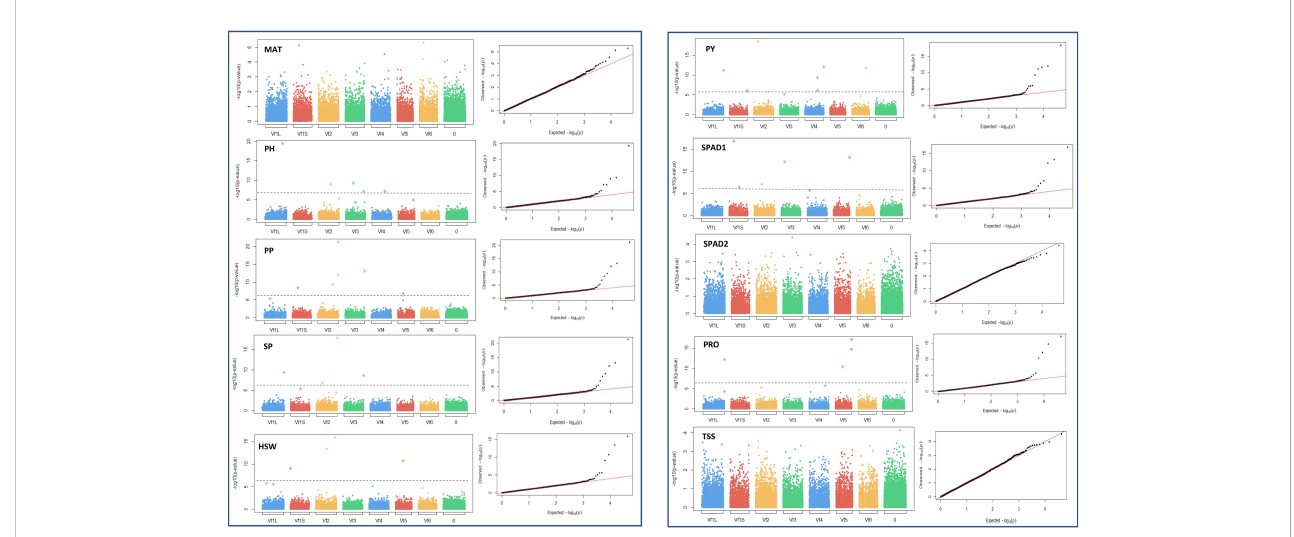
FIGURE 5 Manhattan plots and quantile-quantile (Q-Q) plots of the GWAS results for the 10 traits studied in control conditions. MAT, maturity date; PH, plant height; PP, number of pods per plant; SP, number of seeds per plant; HSW, 100 seed weight; PY, plot yield; SPAD1 and SPAD2, chlorophyll content at the beginning of the stress treatment and about 4 weeks after onset of drought stress, respectively. PRO, free proline content; TSS, total content of soluble sugars. Bonferroni threshold (-log10 (p) > 5.87), is represented by a continuous grey line. X-axis represents the six faba bean chromosomes. The biggest metacentric chromosome I is divided in two corresponding to the large (L) and short (S) arms. Chromosome 0 stands for unknown